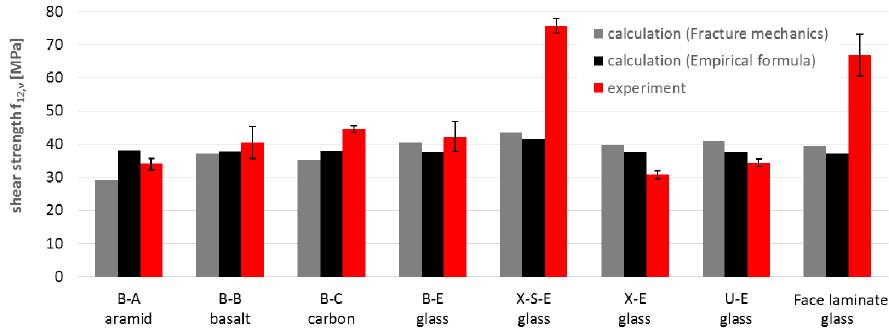
Figure 15. Comparison of shear strength f 12,v obtained by calculation and experiment.